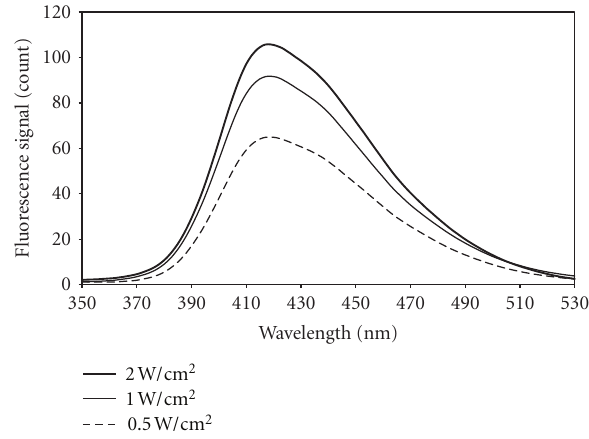
Figure 2: Recorded fluorescence emission spectrum from the TA solution containing GNPs in the field of 1MHz ultrasound waves at intensities of 0.5, 1, and 2W/cm 2 in continuous mode, excitation wavelength = 310 nm, and emission and excitation band width =